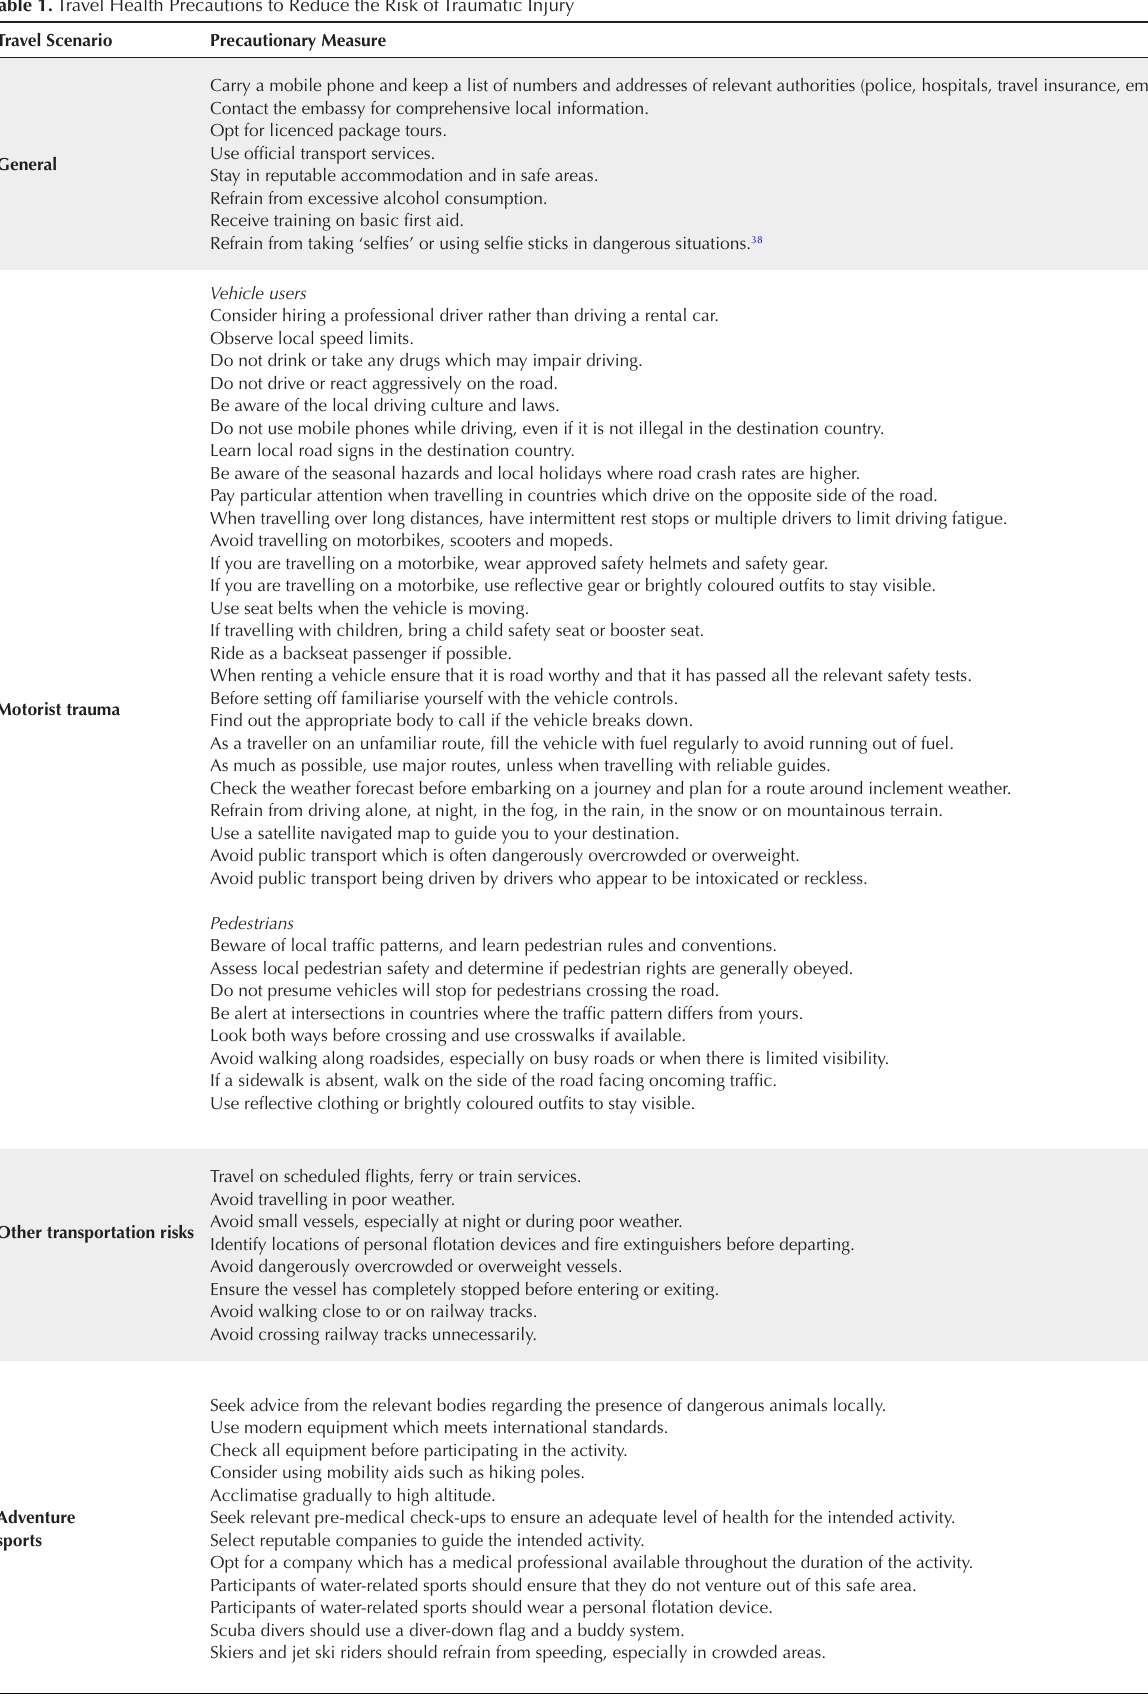
Table 1. Travel Health Precautions to Reduce the Risk of Traumatic Injury Travel Scenario Precautionary Measure